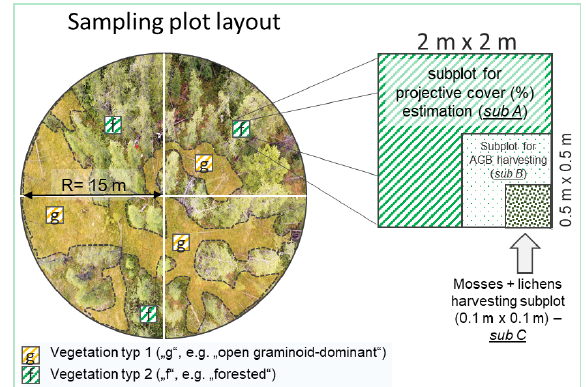
Figure A1. Sampling scheme of the 2018 expedition vegetation survey. Projective cover of tall shrubs and trees was estimated on a circular sample plot with a radius of 15m (after Shevtsova et al.,